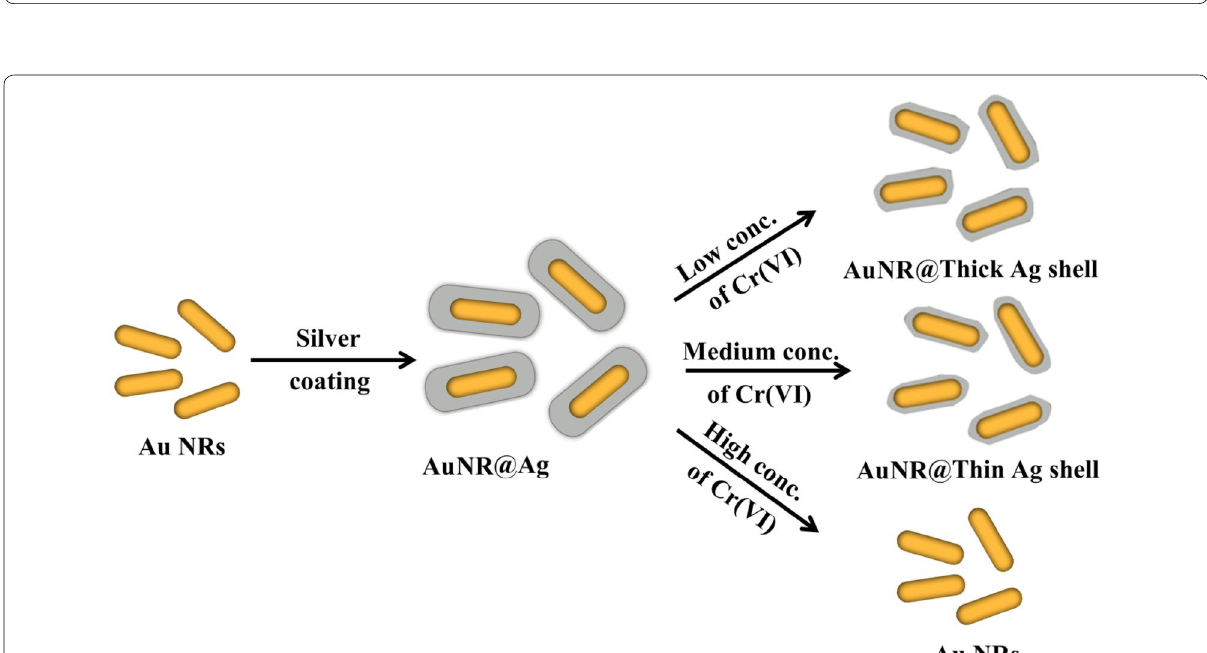
Scheme 1 Schematic mechanism of sensing Cr(VI) based on etching of the AuNR@Ag